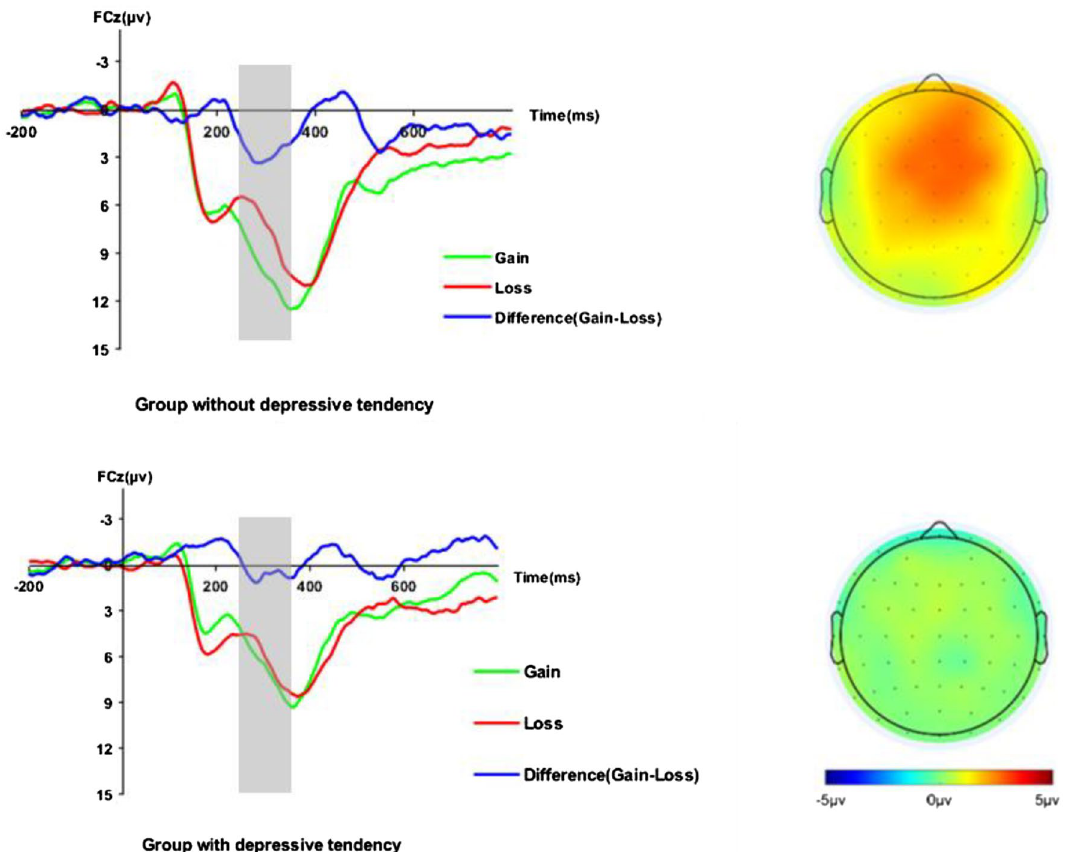
Figure 2. Left: Grand average waveforms for gain, loss and difference (ΔRewP). Right: Headmaps displaying the scalp distribution for the gain–loss difference 250–350 ms post-feedback among the participants with depressive tendencies and those without,